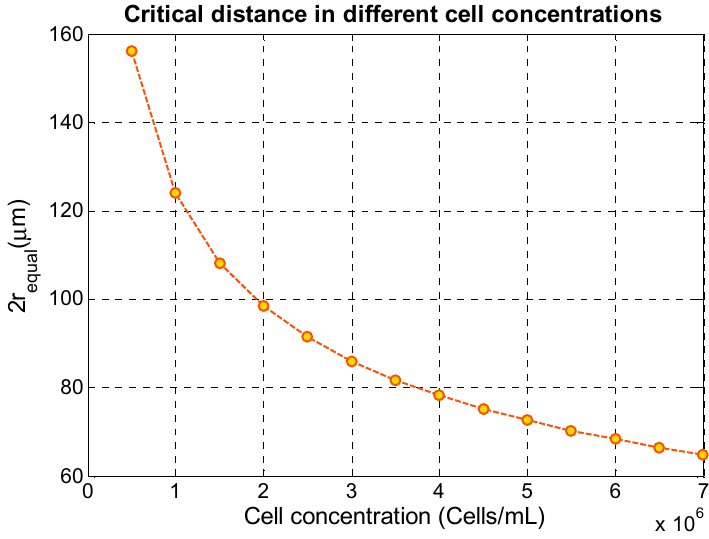
Figure 5. Center-to-center distance between two neighboring particles in a uniform distribution of MCF-7 as a function of different cell concentrations.